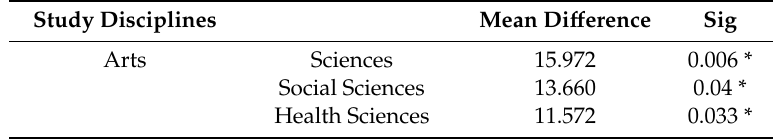
Table 5. Post hoc test for GSLTPAQ among students of di ff erent study disciplines.